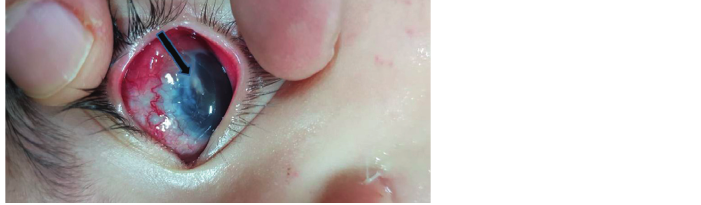
Figure 1: An arrow pointing to a dense fibrous reaction around the tube causing IOP to increase above target levels.